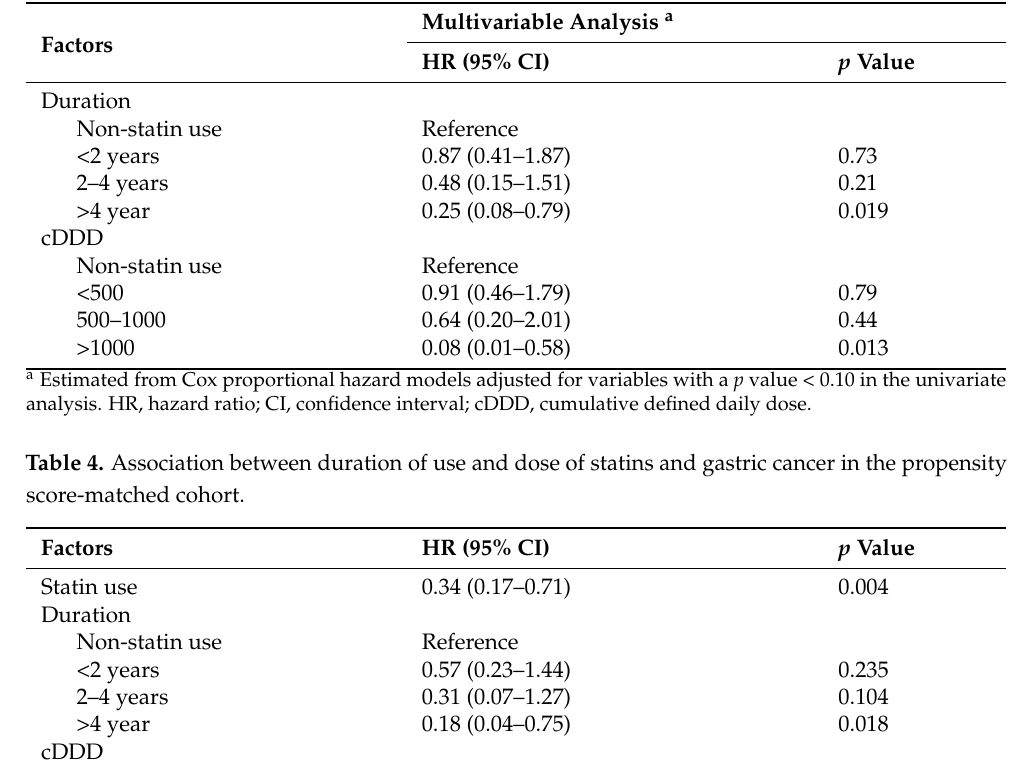
Table 3. Association between duration of use and dose of statins and gastric cancer.